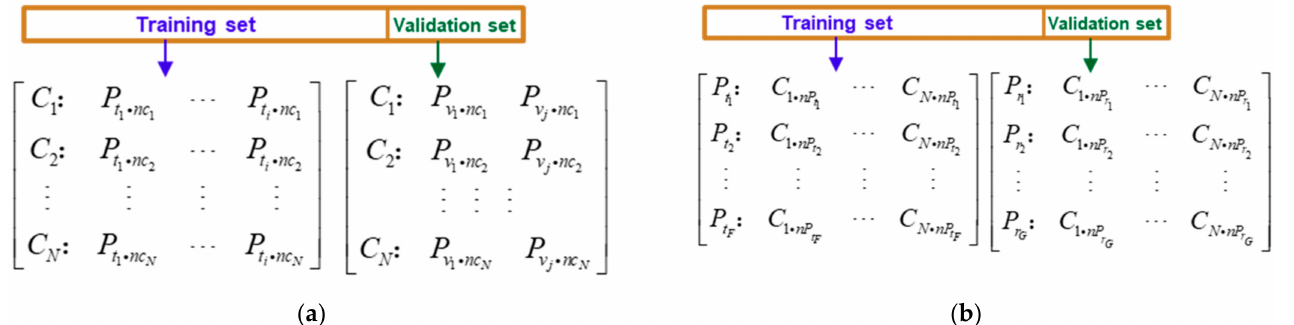
Figure 3. Class-balanced Train/Val split and random Train/Val split according to the number of photos. ( a ) Train/Val Split based on Class-Balanced. ( b ) Train/Val Randomly Split based on the Radio of Photos